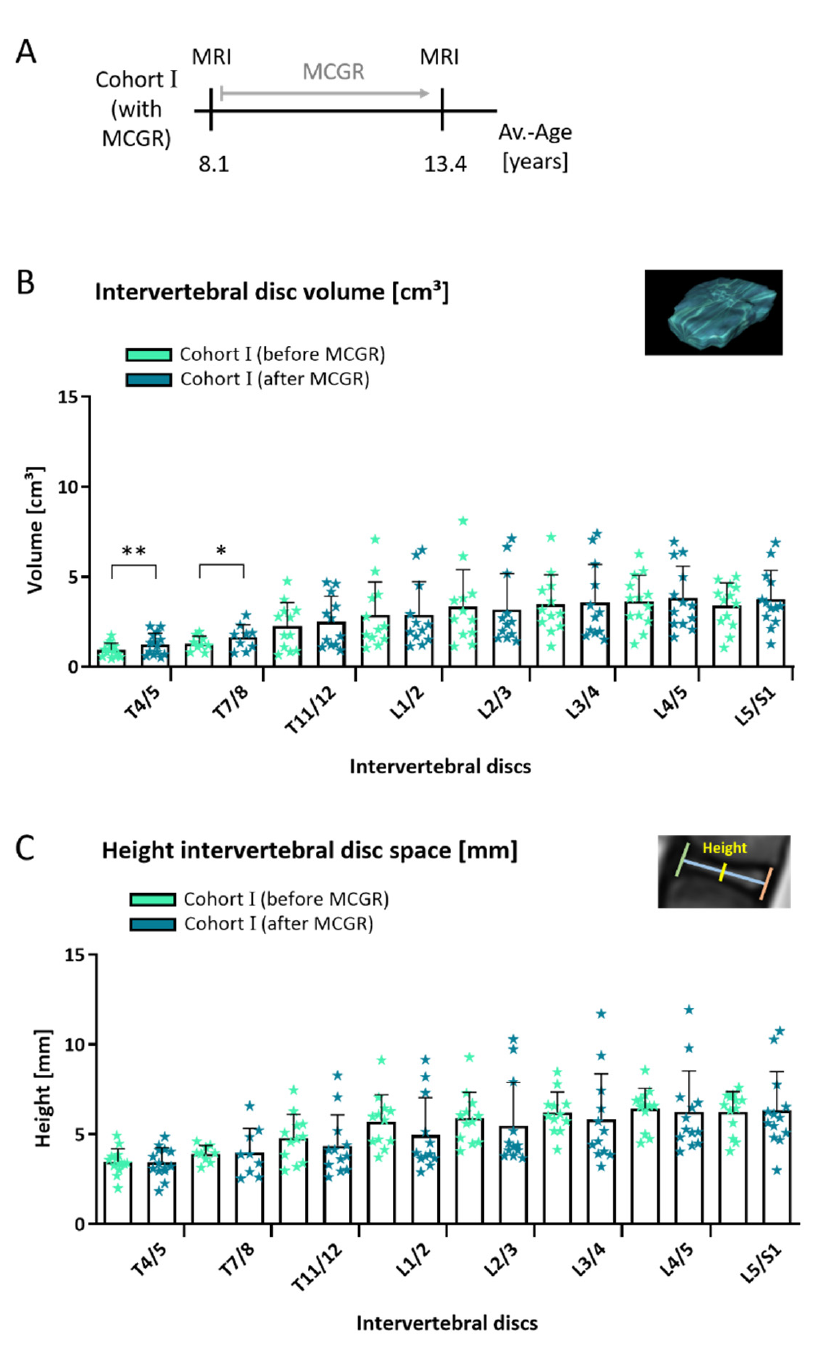
Figure 5. Intervertebral disc volume in children before and after 5.1 years of MCGR treatment. In cohort I, MRI measurements of children with spinal deformity were compared before and after 5.1 years of MCGR treatment ( A ). No significant changes in intervertebral disc volumes ( B ) and height of the intervertebral disc space ( C ) were seen after 5.1 years in the lower thoracic and lumbar spine. (B and C) Paired t -test; mean +/ − SD; early (Cohort I before MCGR) and late (Cohort I after MCGR) time point: n = 14 (T4/5), n = 9 (T7/8), n = 12 (T11/12), n = 12 (L1/2), n = 12 (L2/3), n = 12 (L3/4), n = 13 (L4/5) and n = 13 (L5/S1); statistical level of significance p < 0.05 (*), p < 0.01 (**).